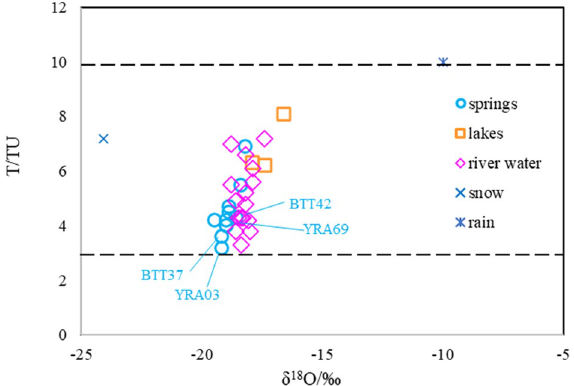
Figure 6. Plot of δ 18 O vs. T values of water samples. Karst springs with flow of > 50 L/s are marked.